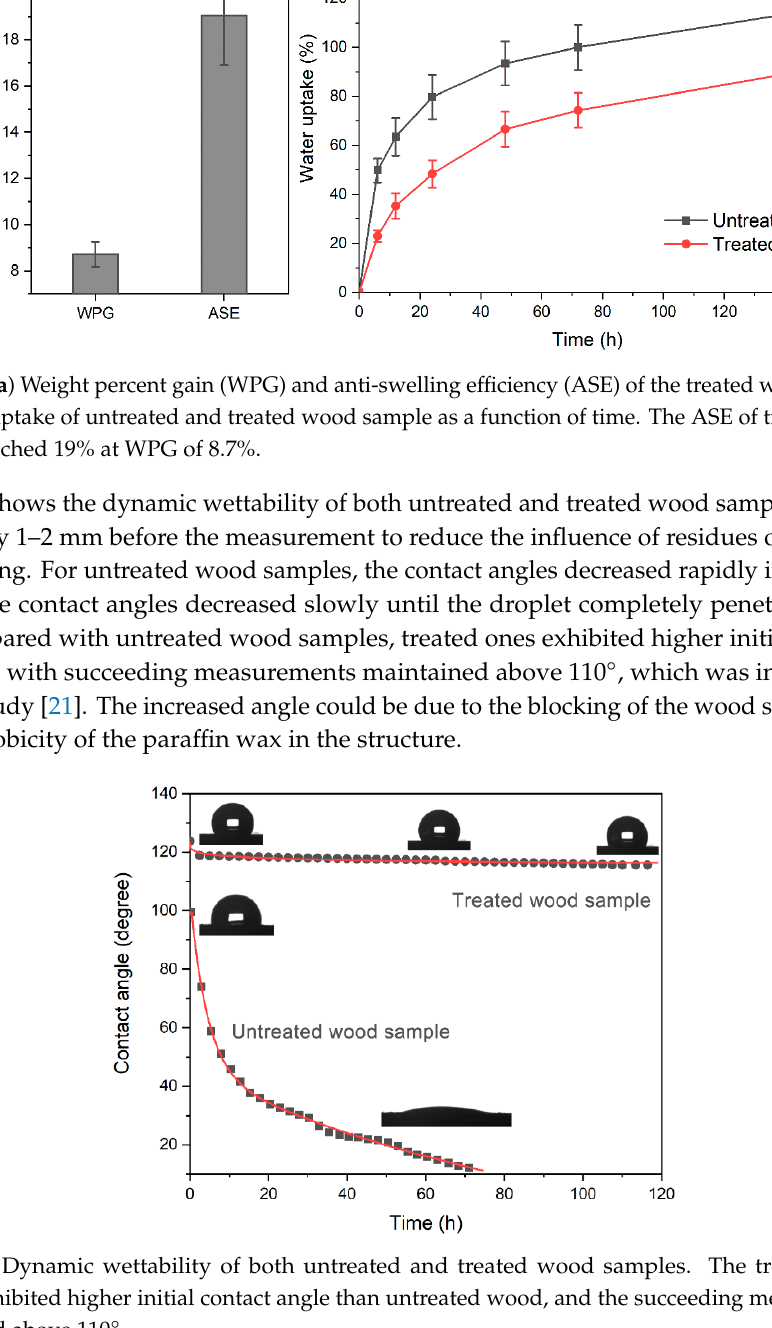
Figure 9. Thermogravimetric (TG) and differential thermogravimetric (dTG) curves of untreated and treated wood samples. The treated wood sample had higher weight residue than untreated wood. 4. Conclusions The low dispersed SiO 2 nanospheres were synthesized with the diameter ~76 nm, and these nanospheres were effective in stabilizing the paraffin Pickering emulsion. Due to the filling of wax and SiO 2 nanospheres, the impregnation with emulsion could endow wood with moderate ASE, high water resistance, and low wettability. The thermal stability of wood was also improved due to the presence of nano-SiO 2 . This preliminary investigation provides a promising method to enhance the dimensional and thermal stability of wood. However, more efforts are needed in the future to investigate the effects of many treatment variables, such as particle content, particle size, surface polarity, and the emulsion process, on the properties of emulsions and impregnated wood. Author Contributions: Methodology and data curation, R.L., X.L., Y.Z., C.G., J.L. (Junjia Liu) and M.W; writing—original draft preparation, R.L. and X.L.; supervision, Y.D.; writing—review and editing, Y.D., J.S. and J.L. (Jianzhang Li); project administration and funding acquisition, Y.D. All authors have read and agreed to the published version of the manuscript. Funding: This research was funded by Natural Science Foundation of Jiangsu Province, grant number BK20190754, and Student Practice Innovation and Training Program of Jiangsu Province, grant number 201910298001Z.